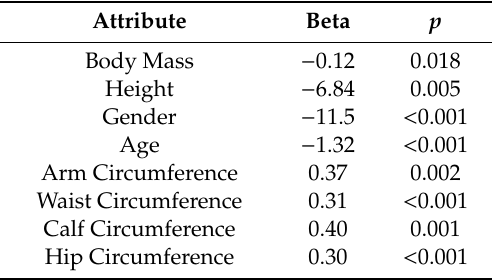
Table 3. Regression coe ffi cient (Beta) and significance ( p ) for each analyzed variable of the model, in relation to the body fat percentage.